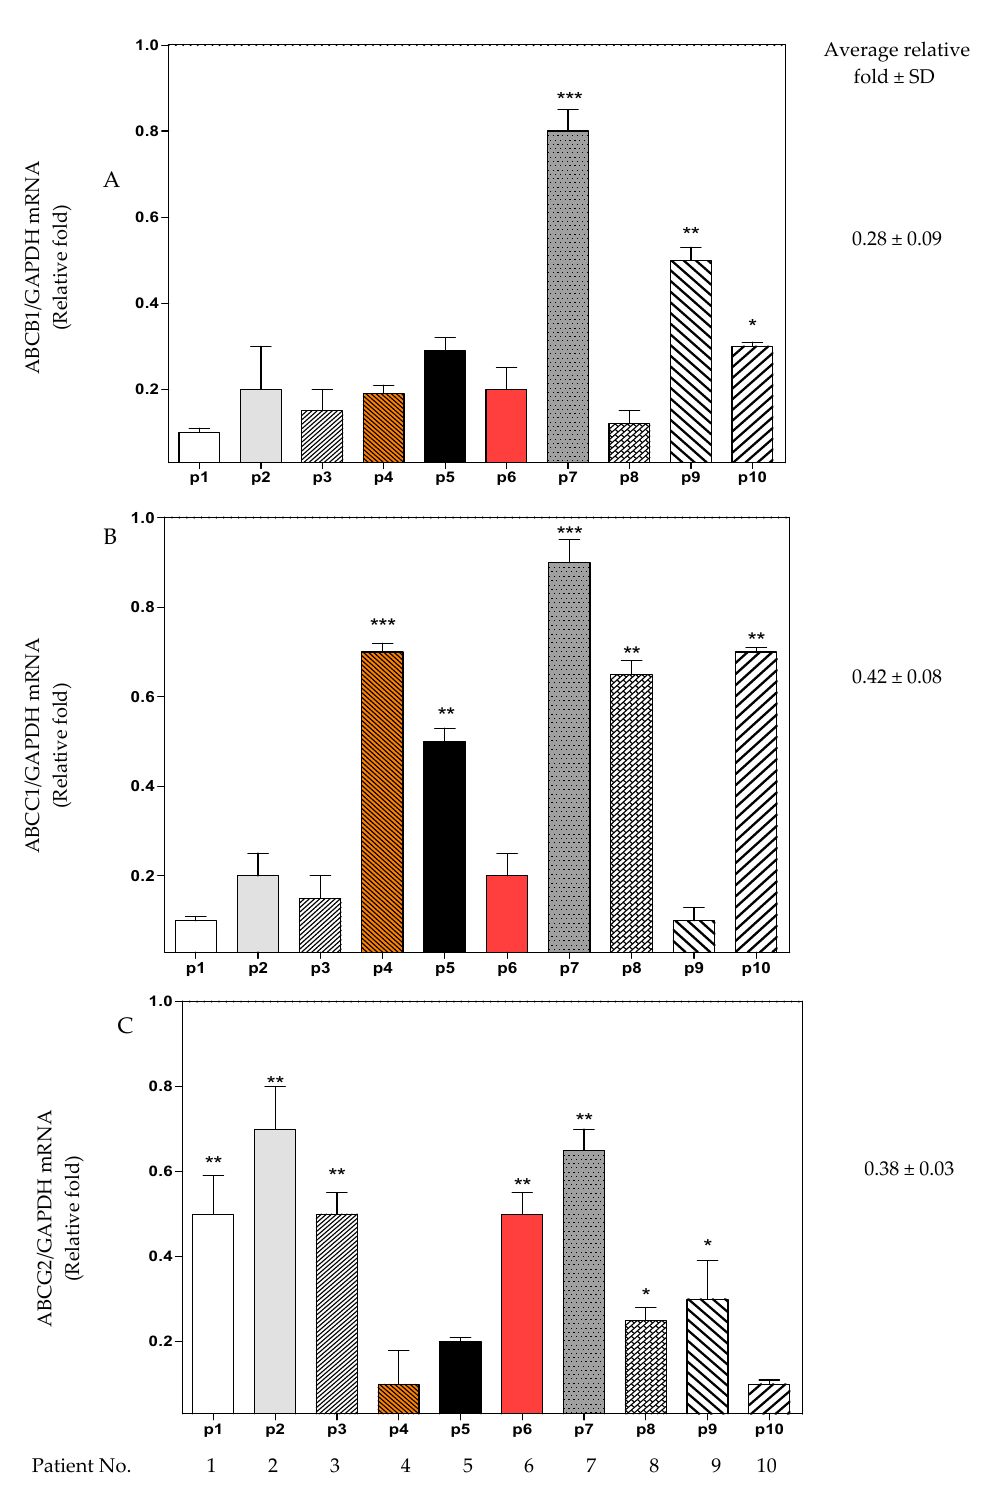
Figure 4. Total mRNA was isolated from the 10 Saudi patients (p1–p10) and quantified by RT-PCR with ( A ) ABCB1, ( B ) ABCC1, and ( C ) ABCG2 primers. The results were expressed as relative fold change (average ± SD, n = 3, x2 independent experiments) compared with GAPDH (1-fold change). W a : wild type KRAS, M b : mutated KRAS. Statistical differences (one-way ANOVA and Tukey’s post-hoc): p < 0.05 (*), p < 0.01 (**), p < 0.001 (***) were considered